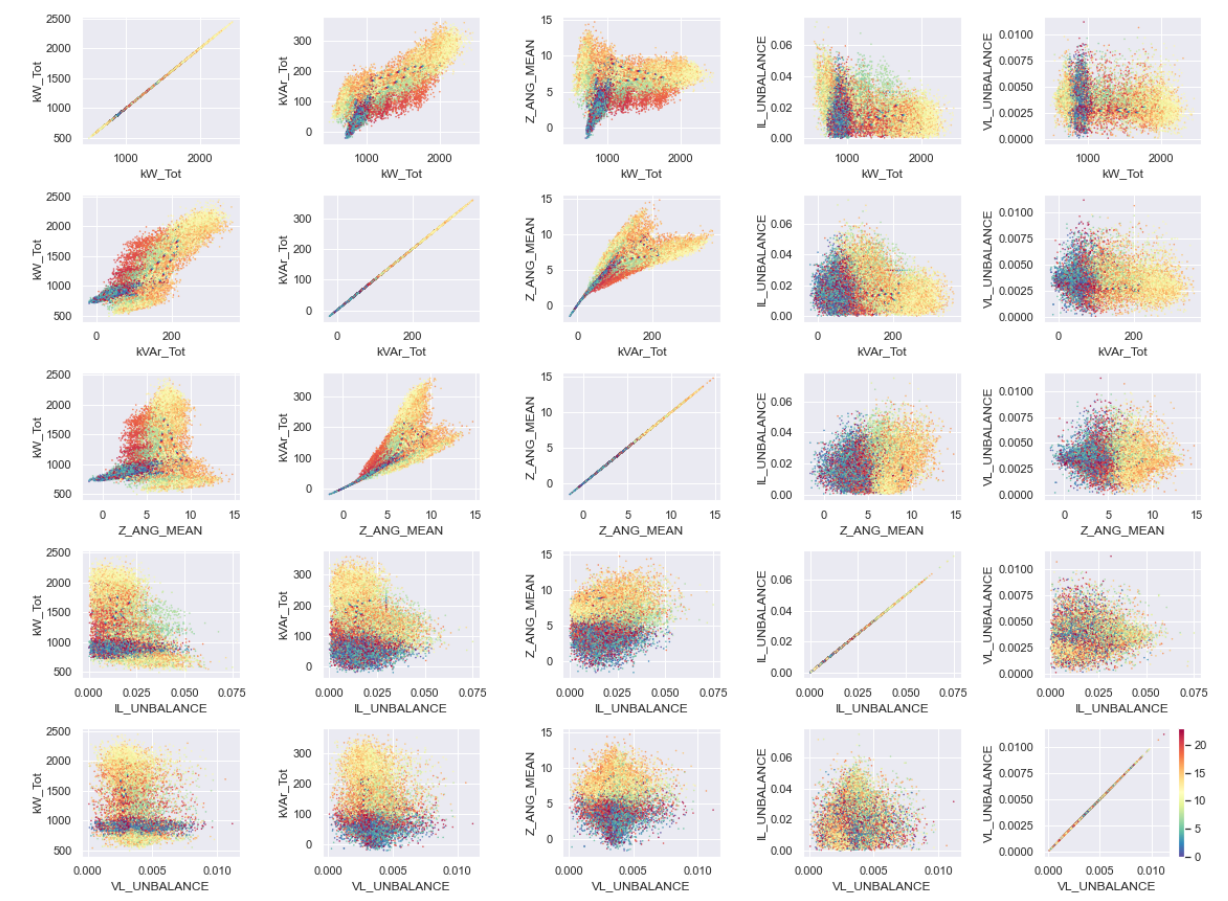
Figure 21. Correlograms of the extended variables in Scenario B. Each color represents the hour of the day.